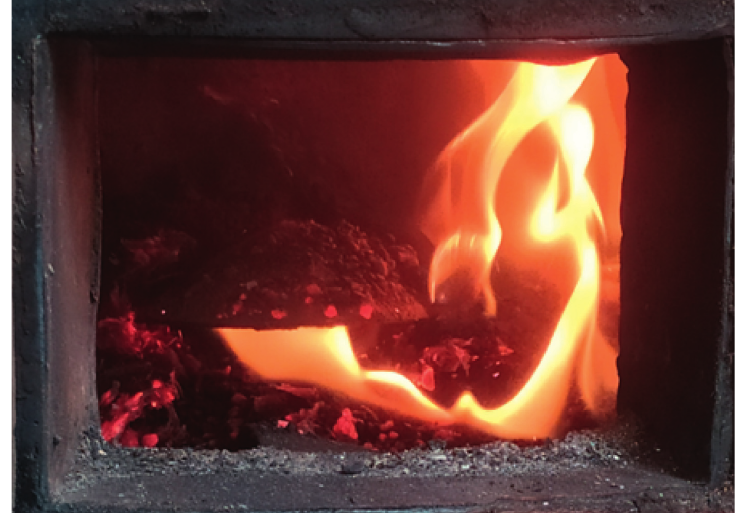
Figure 15: Display of combustion fire in the combustion